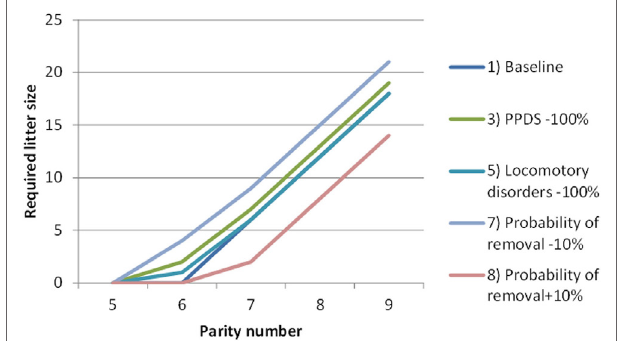
FigUre 6 | The minimum litter size (by parity number) that a sow must to exceed in order to remain in the herd, according to five scenarios simulated by the dynamic programming model. PPDS, postpartum dysgalactia